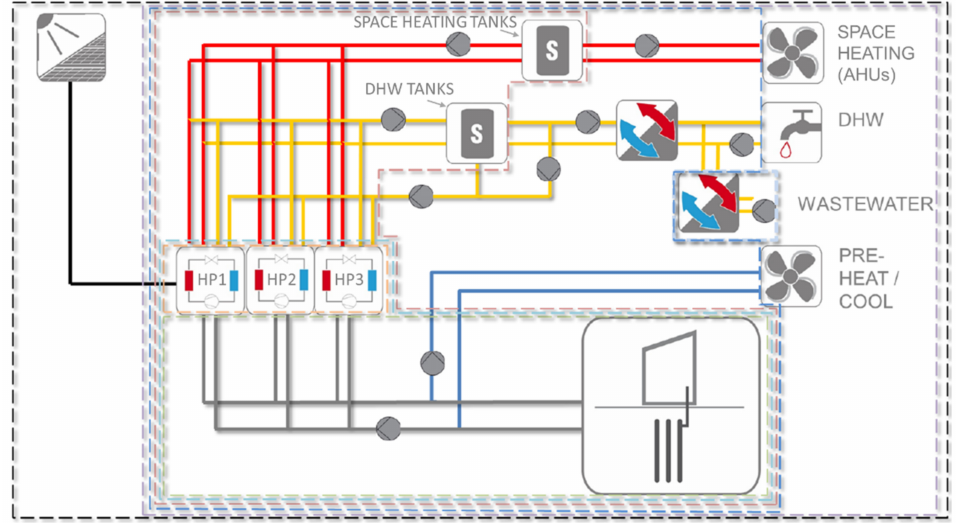
Figure 3. Testbed EM: simplified schematic of the heat pump system. Pictograms by TU Braunschweig IGS, used with permission.